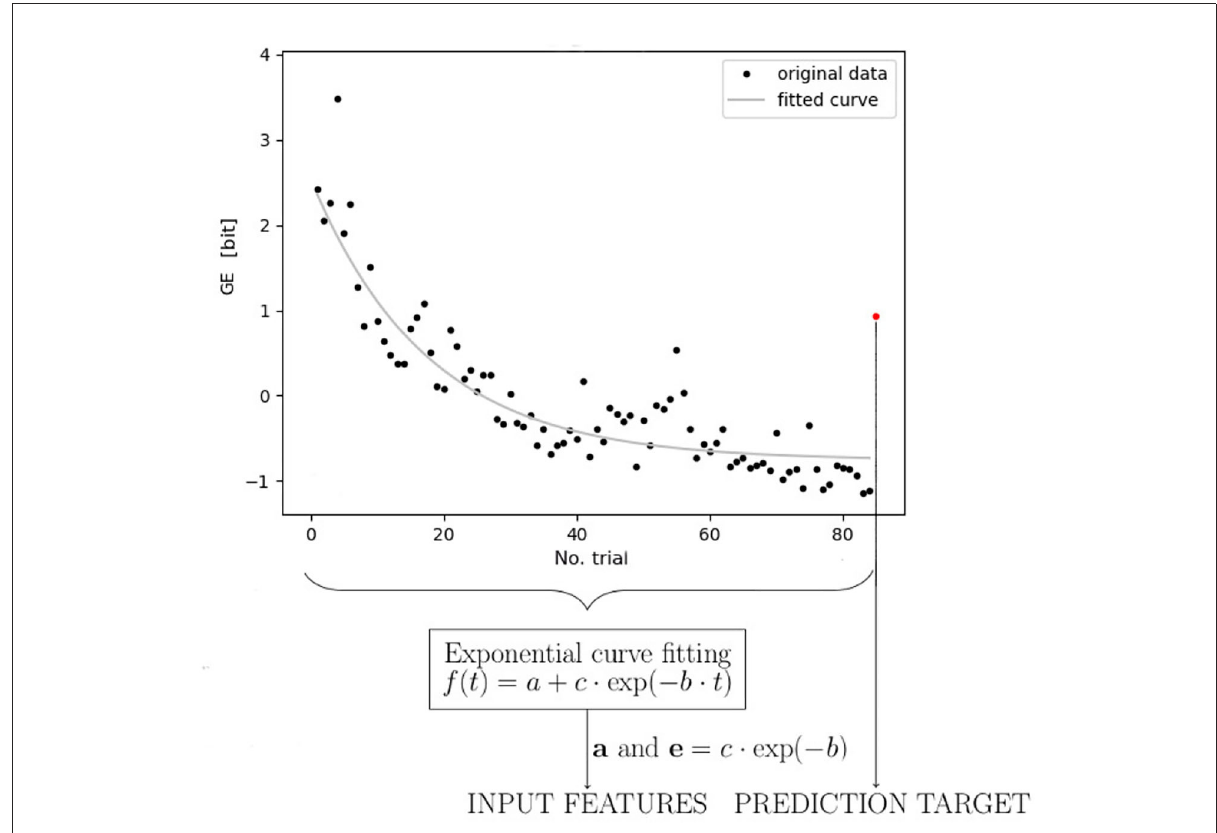
FIGURE4 Diagram of the modeling stages. The first stage , illustrated as black dots in the figure, depicts fluency calculation for the training data of one participant, and the last red dot symbolizes climbing fluency for the transfer route in the post-test trial. In the second stage (learning dynamics modeling), the exponential function is fitted to the training data signal, except for the transfer test value (unmatched). Subsequently, the exponential function parameters of all metrics (entropy, jerk, immobility ratio, and climbing duration) are utilized in the prediction algorithm ( third stage ) as an input set of features, while the transfer value is utilized as an output (target). This stage models the learning generalization. The exemplary entropy data in the graph have been standardized